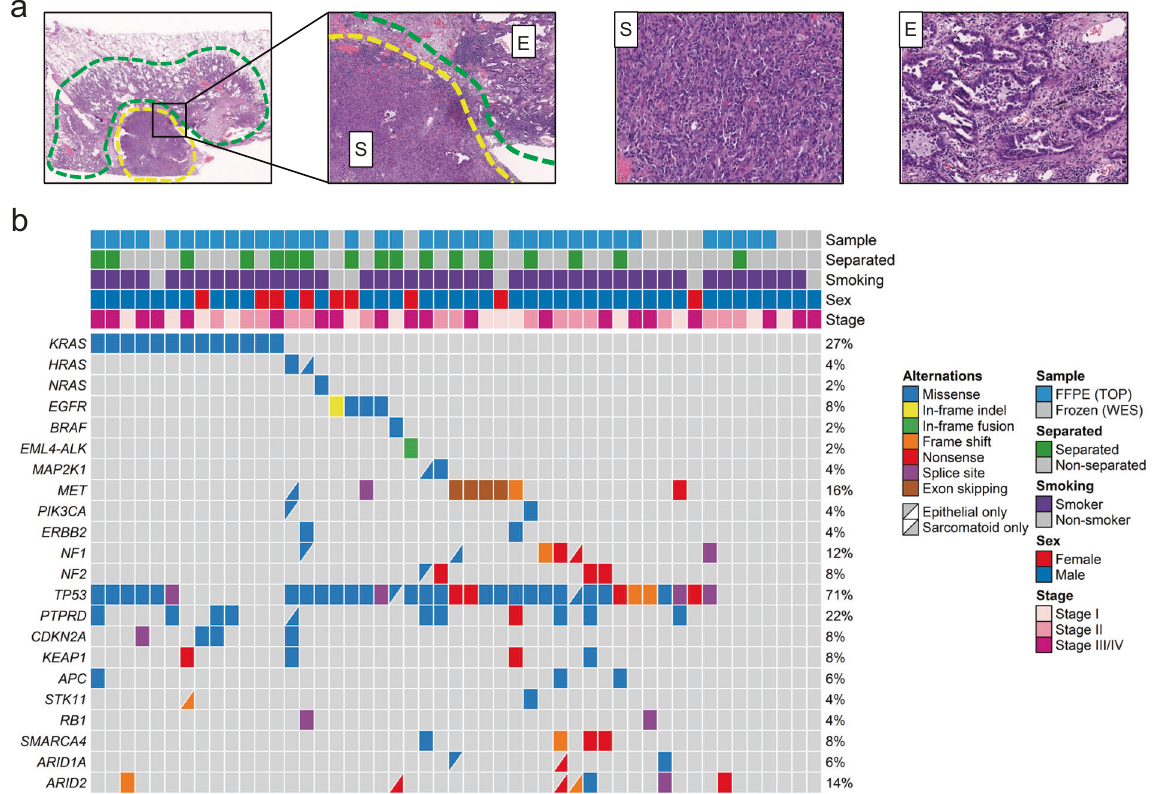
Fig. 1 Representative images and genomic alterations of pulmonary pleomorphic carcinomas. a This case comprises adenocarcinoma (green area) and sarcomatoid (yellow area) components (hematoxylin and eosin staining). Magni fi ed images of the epithelial (E) and sarcomatoid (S) components are shown. b Mutations in KRAS were detected in 13 patients (27%). Other activating mutations were detected in EGFR (8%), HRAS (4%), NRAS (2%), BRAF (2%), and MAP2K1 (4%). MET exon 14 skipping (4%) and EML4-ALK fusion (2%) were detected using RNA sequencing. These driver mutations were mutually